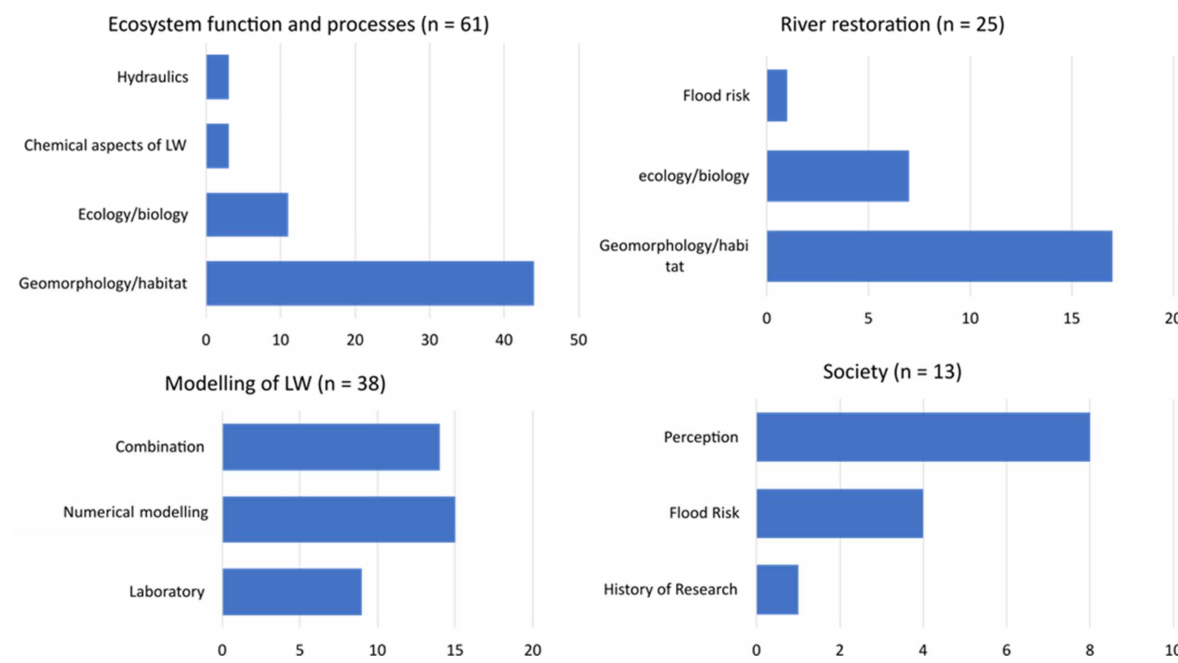
Figure 4. Categories of key areas of research and article distribution.